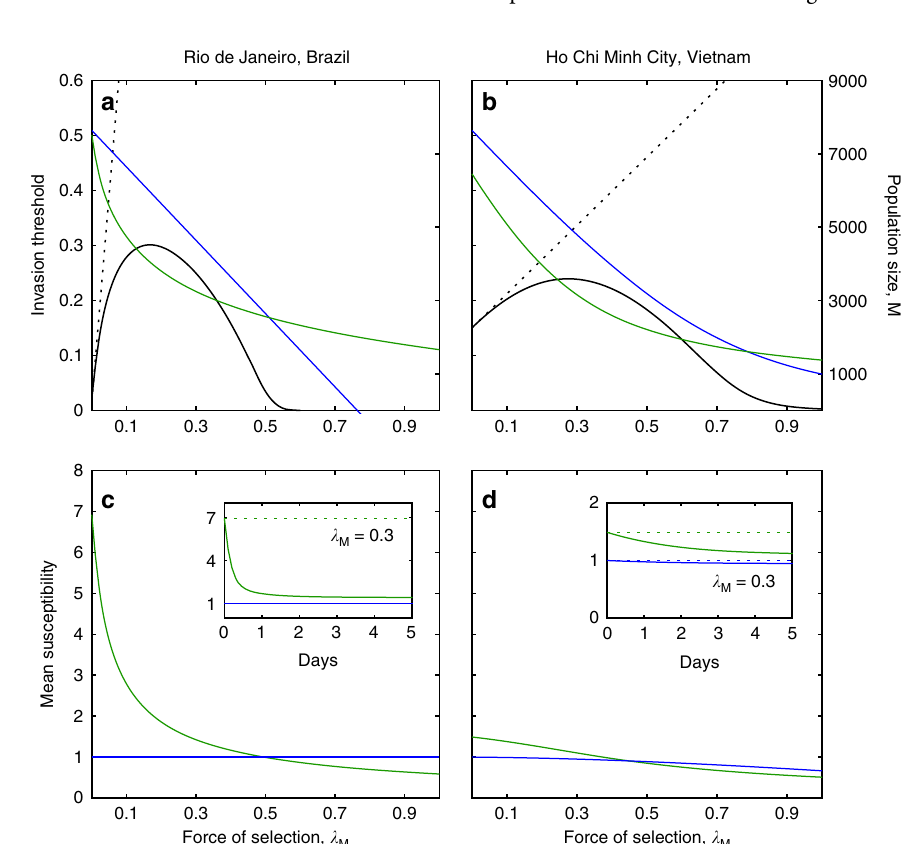
Fig. 2 Threshold for Wolbachia invasion and cohort selection on susceptibility. a , b Invasion threshold for Wolbachia carriers over a range of forces of selection by mosquito pathogens, obtained by introducing the susceptibility distributions estimated in Fig. 1 in a population dynamic model described in Methods section (solid back curves). Dotted lines show the results of the same calculation if only the means had been used to describe the susceptibility of each population. Other model outputs are the population sizes of Wolbachia -free (Wolb − , in blue) and Wolbachia -carrier (Wolb + , in green) populations at fi xation, in Rio de Janeiro, Brazil ( a ) and Ho Chi Minh City, Vietnam ( b ). c , d Effects of cohort selection on the mean susceptibility of each population once equilibrium has been reached under a range of selection forces. The insets illustrate how mean susceptibilities develop over time, from the moment populations are released until equilibria are established, under one speci fi c force of selection ( λ M = 0.3). The changes in mean susceptibility depicted in the insets are accompanied by reductions in variance. Variance-to-mean ratios in Wolb + populations changed from 20.83 to 10.10 in Brazil ( c ), and from 7.200 to 0.7715 in Vietnam ( d